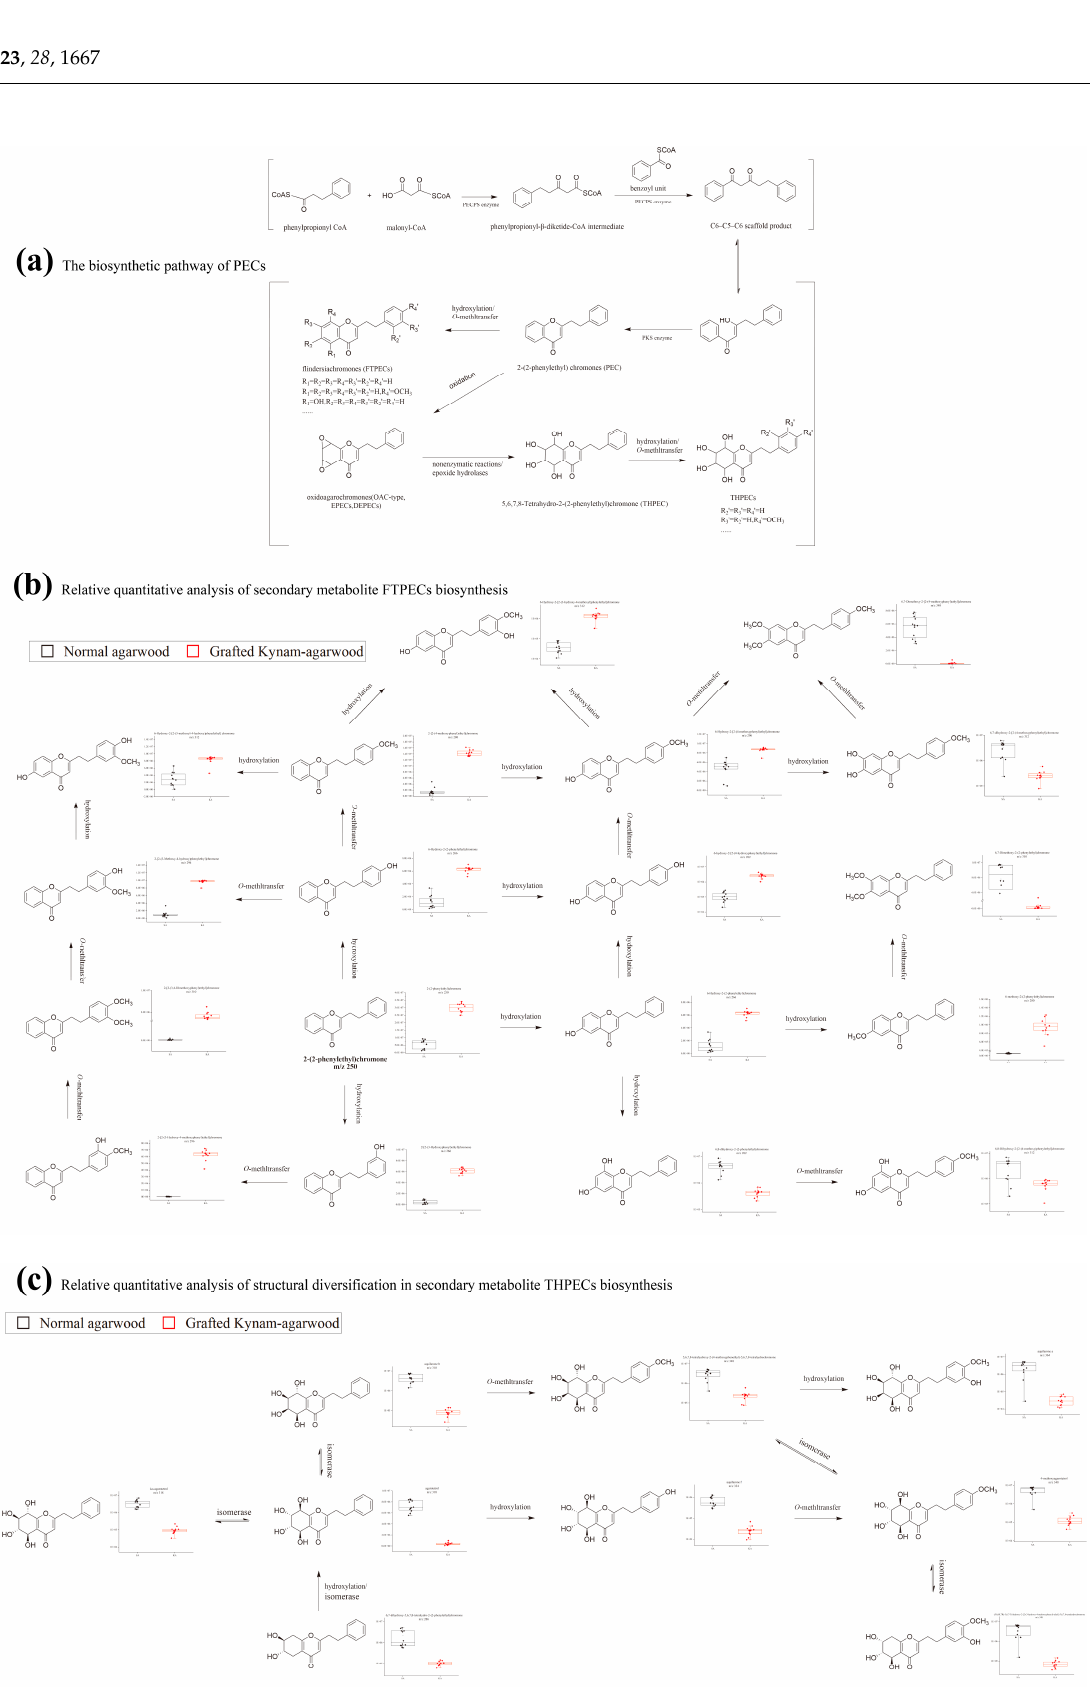
Figure 6. Differential analysis of PECs biosynthesis pathway between GKA and normal